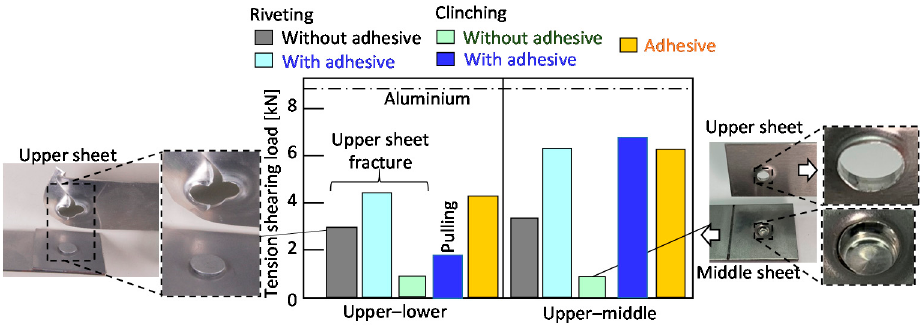
Figure 29. Tension-shearing loads of riveted and clinched joints for the upper aluminium alloy sheet.